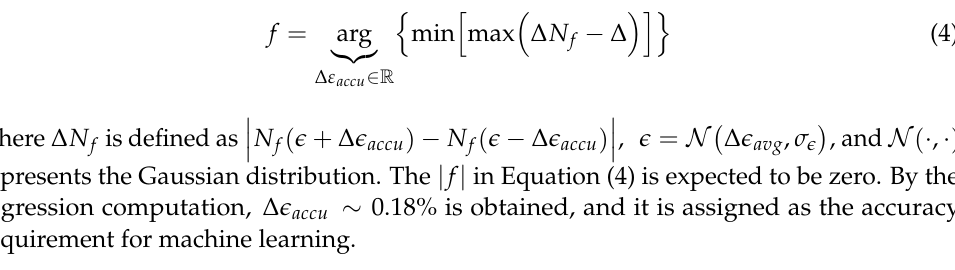
Figure 9. The boxplot of the plastic strain incremental of the 81 data points [15] (Copyright 2020 EuroSimE).